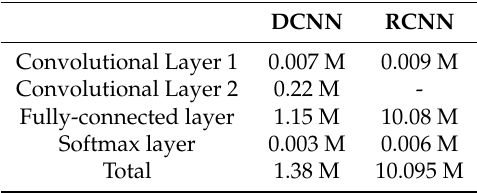
Table 15. Parameters per layer of the convolutional neural